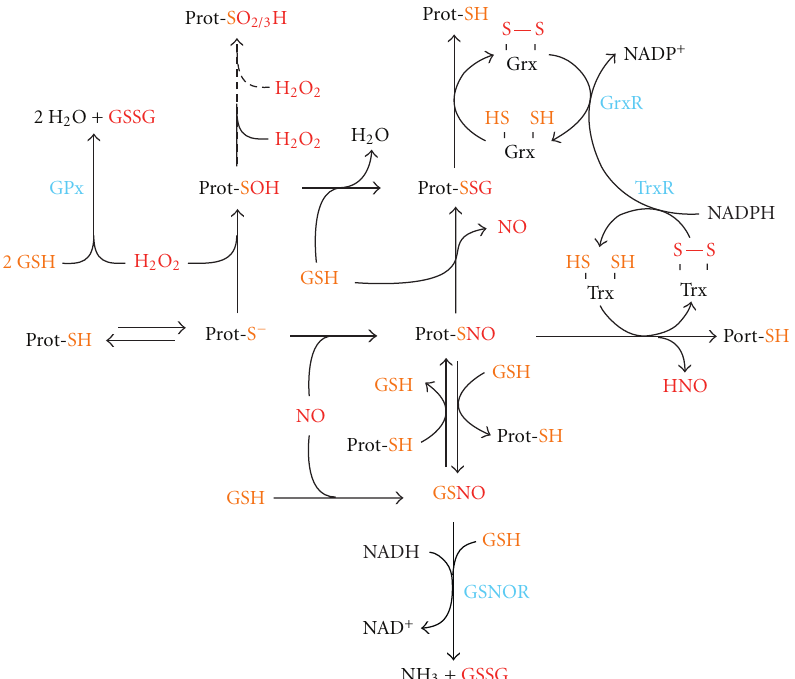
Figure 2: Redox network underlying protein thiol-dependent signaling. The key role of sulfur chemistry in cell signaling depends on the capability of specific cysteine residues, named reactive cysteines , of redox sensing proteins (Prot-SH) to undergo reversible oxidations upon deprotonation (formation of a thiolate adduct, Prot-S − ). The net negative charge enhances the nucleophilic nature of sulfur and allows the generation of several adducts upon reaction with prooxidant compounds (red-colored). In particular, the encounter of a Prot-S − with H 2 O 2 leads to the hydroxylation of the sulfur moiety with the formation of a still reducible sulfenate derivative (SOH). Further H 2 O 2 -mediated oxidations modify sulfur to sulfinic (SO 2 H) or sulfonic (SO 3 H) acid species, that are irreversible oxidations, except for the former, that, in some cases (e.g., the sulfinic form of peroxiredoxin), can be reduced back at the expense of ATP by means of sulfiredoxin-mediated catalysis (not shown in the figure). Prot-S − can also undergo S -nitrosylation, thereby generating a Prot-SNO adduct (see Figure 1). Both Prot-SNO and Prot-SOH can exchange with reduced glutathione (GSH), leading to the formation of the more stable S -glutathionylated species (Prot-SSG). Prot-SSG and Prot-SNO are reduced back, respectively, by the glutaredoxin/glutaredoxin reductase (Grx/GrxR) and thioredoxin/thioredoxin reductase (Trx/TrxR) systems, at the expense of NADPH. In addition, Prot-SNO can undergo transnitrosylation reactions with GSH, thereby forming S -nitrosoglutathione (GSNO). This reaction underlies a delicate equilibrium between the redox couples GSH/GSNO and Prot-SH/Prot-SNO that are strictly maintained by GSNO reductase (GSNOR) activity. Indeed, by using GSH-provided reducing equivalents and NADH as cofactor, GSNOR completely reduces GSNO to glutathione disulfide (GSSG) and ammonia (NH 3 ), thereby deeply a ff ecting Prot-SNO concentration. Intracellular GSH availability is also important to detoxify from H 2 O 2 toxicity, as it is the elective cofactor of glutathione peroxidase (GPx). Therefore, GPx and GSNOR indirectly impact (i.e., via GSH oxidation to GSSG) on the total level of the reversibly oxidized proteins (Prot-SOH and Prot-SNO), by directly regulating the concentration of H 2 O 2 and